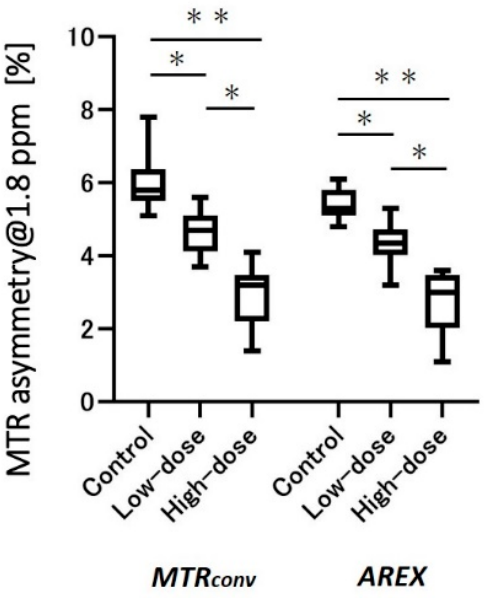
Figure 4. MTR asymmetry graphs at 1.8 ppm in the testes of control, low-, and high-dose cisplatin- treated models. * p < 0.05, ** p < 0.001. MTR, magnetization transfer ratio; MTR conv , conventional analysis metric magnetization transfer ratio; and AREX , apparent exchange-dependent relaxation.